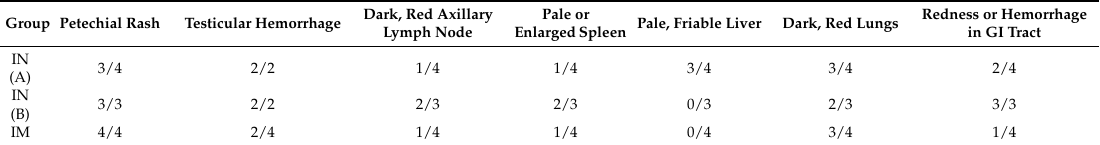
Table 2. Summary of macroscopic findings.